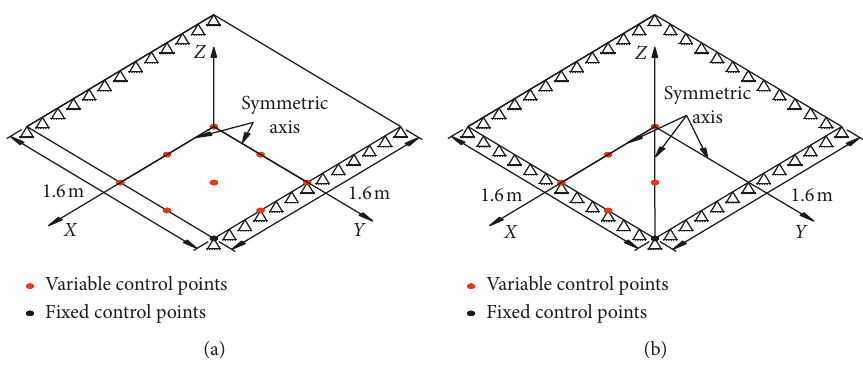
Figure 12: Location of control points through Approach 2. (a) Shell 2. (b) Shell 3.